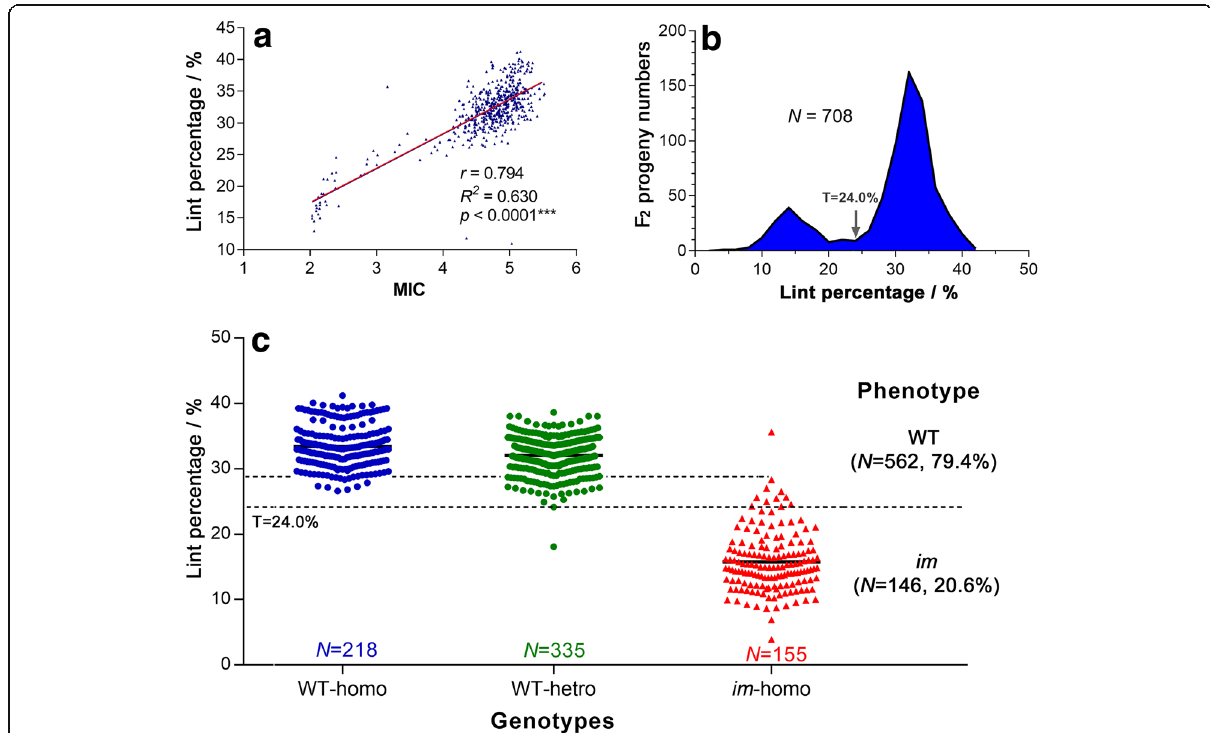
Fig. 3 Segregation and frequency distribution curve of the F 2 population based on lint percentage. a Correlation of lint percentage with MIC value of F 2 progeny composed of 599 plants that were measured by both lint percentage and MIC measurements. b Frequency distribution curve of lint percentage. 24% was determined as a threshold lint percentage for classifying the im from WT phenotype. c Comparisons of lint percentage-based phenotypes with genotypes. The lint percentage values of the 708 F 2 progeny plants were compared with genotyping results. T, threshold value; N, sample number; M, measureable; U.M.,